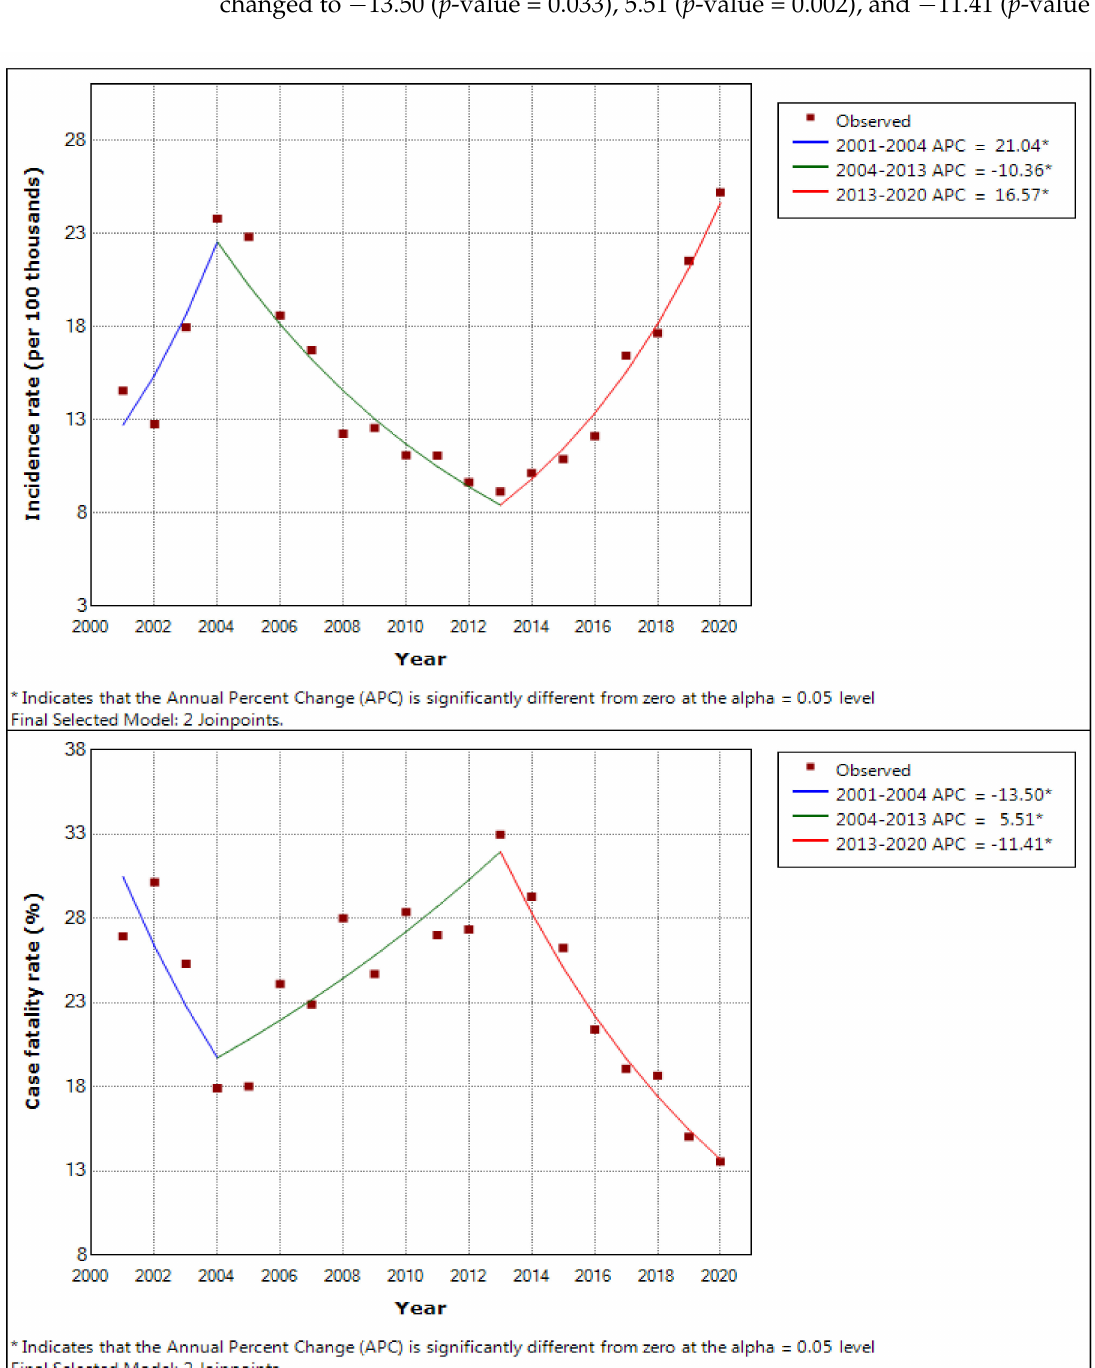
Figure 4. The incidence and fatality rate trends of all occupational diseases analysed by joinpoint